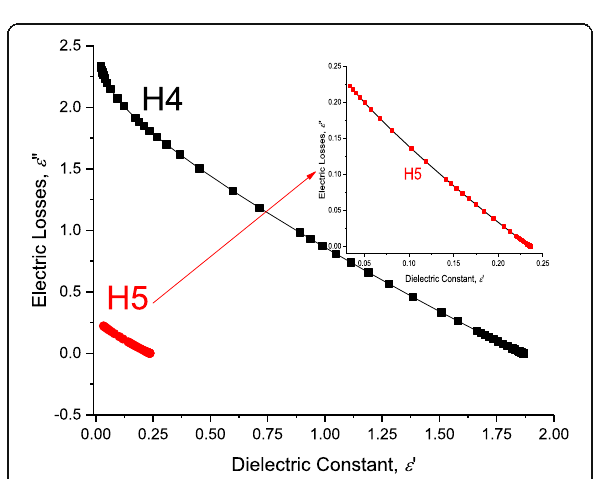
Fig. 24 Cole-Cole curves for the charges at DNA (H4 and H5) at different 298 K. One notices that there is complete departure from the “ semi-circle behavior